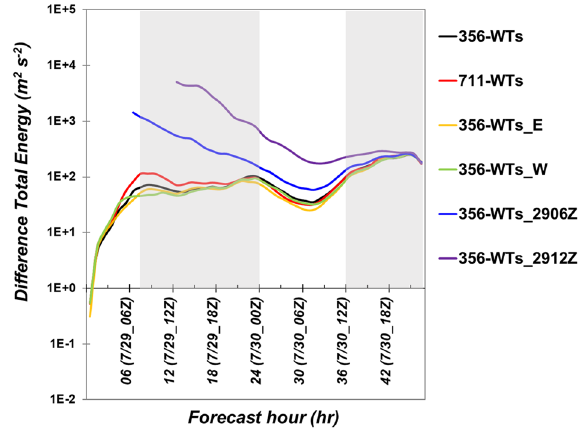
Figure 6. The evolution of estimated Difference Total Energy (DTE, m 2 s −2 ) for all experiments. The black, red, yellow, green, blue and purple lines represent the case 356-WTs, case 711-WTs, case 356-WTs_E, case 365-WTs_W, case 356-WTs_2906Z and case 356-WTs_2912Z, respectively. Grey background indicates the two steadily stages. Plots were produced using NCAR Command Language (NCL) version 6.6.2 37 .